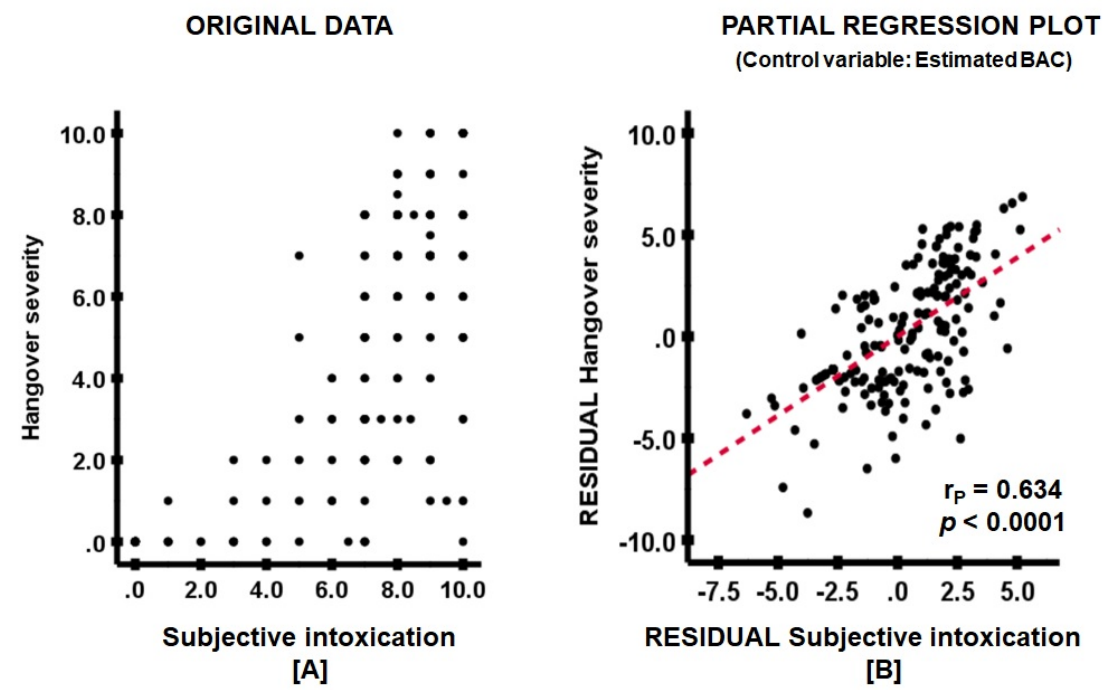
Figure 1. The association between subjective intoxication and overall hangover severity. A partial correlation (r p ) was computed between hangover severity and ethanol elimination rate. ( A ) shows the original data, ( B ) the partial regression plot. The red line represents the partial correlation. Abbreviation: BAC = blood alcohol concentration.